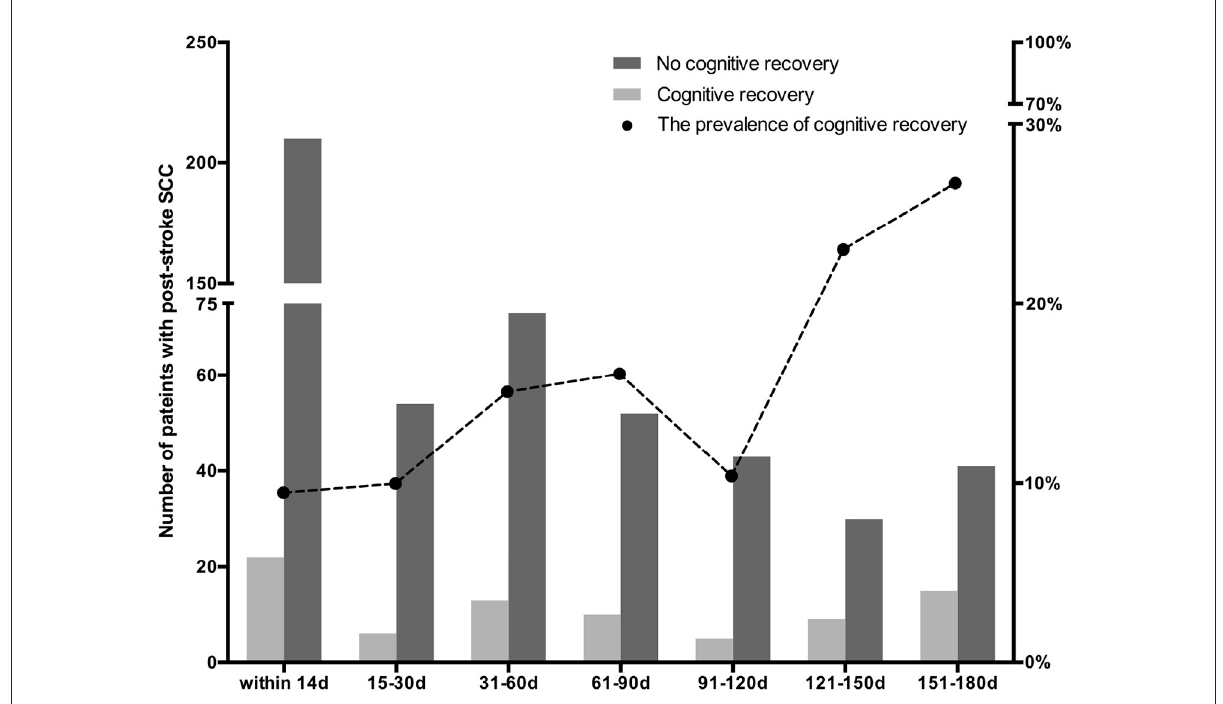
FIGURE1 The prevalence of cognitive recovery in patients with subjective cognitive complaints (SCC) at various time periods after stroke.